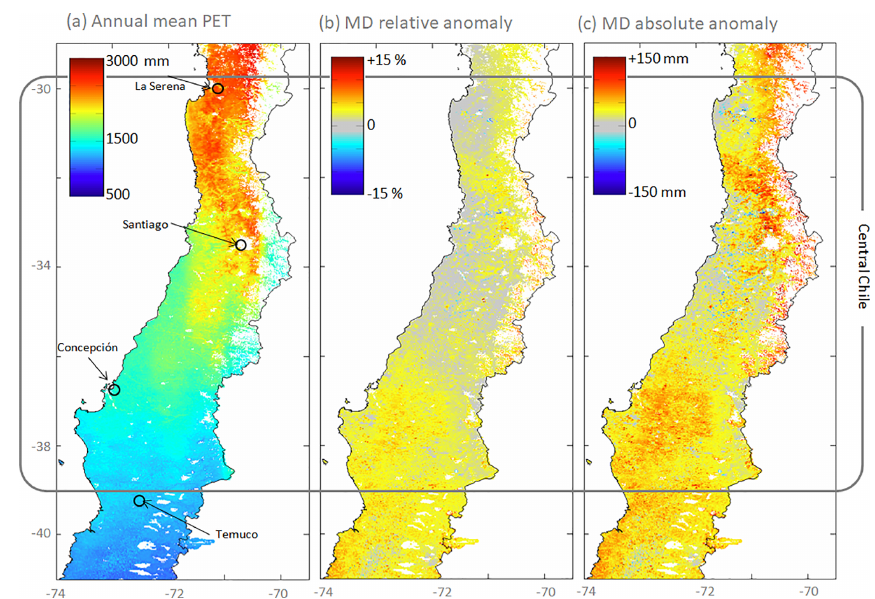
Figure 11. (a) Annual mean MODIS-derived potential evapotranspiration (PET) over central Chile (2001–2015). (b) MD-averaged PET anomalies relative to the long-term mean. (c) MD-averaged PET absolute anomalies.